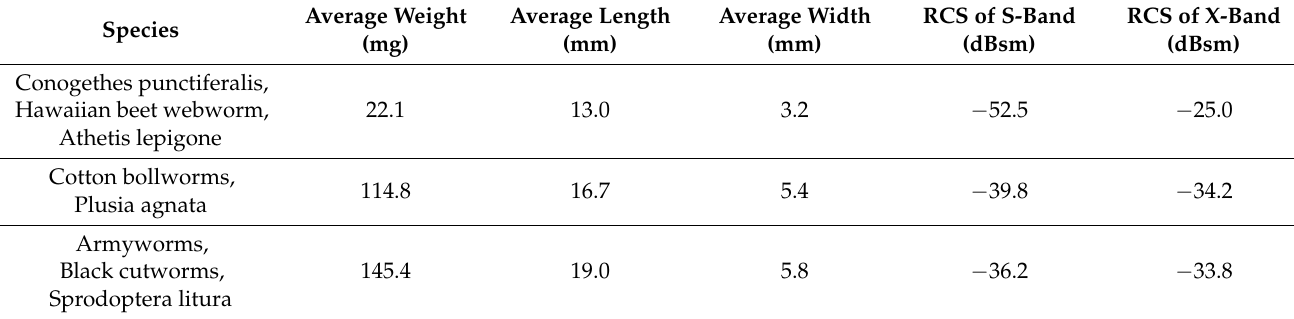
Table 1. Parameters of several insects and their RCSs at different wavelengths. The biometric data were provided by the Chinese Academy of Agricultural Sciences from captured insects in North China. The RCSs were simulated by FEKO simulation software using the prolate spheroid model of a spinal cord